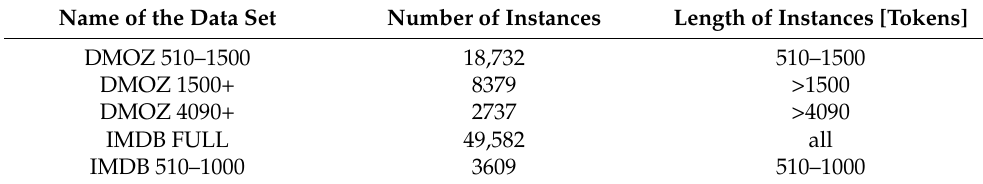
Table 1. Data sets used in this